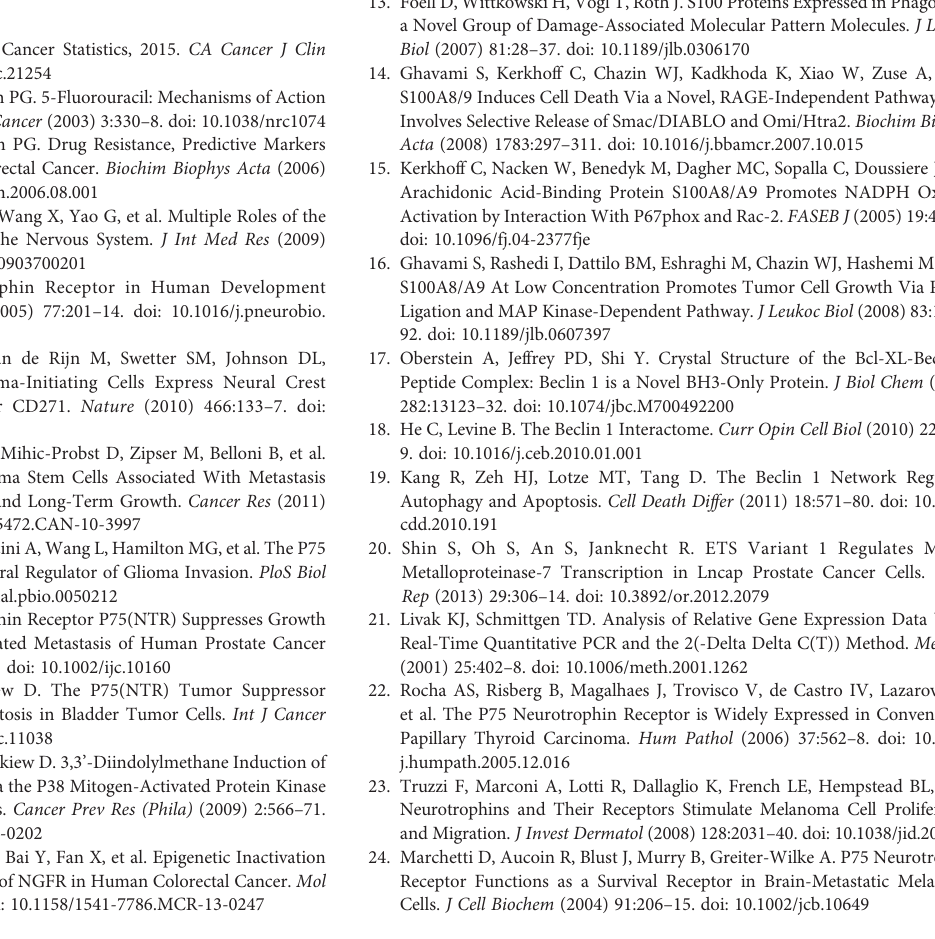
fold change distribution of all probes, excluding the control and fl agged probes. |Fold change| ≥ 1 indicates differentially expressed genes. Supplementary Figure 2 | Volcano plot of the distribution of differentially expressedgenesbetweentheexperimentalandcontrolgroups.Thedottedredand green lines represent the cutoff, a measurement of the gene expression fold change on the X-axis versus a measure of statistical signi fi cance ( − Log10 [P-value]) on the Y-axis. Differentially expressed genes are established at |Fold change| ≥ 1 and P < 0.05 (blue dots). Supplementary Figure 3 | Hierarchical clustering of differentially expressed genes in the experimental and control groups using a Human OneArray v6.1 microarray. A hierarchical clustering tree indicates the gene expression pattern similarities of the 244 genes in the experimental and control groups. The expression levels of the 244 genes are shown by differently colored lumps: red, high (upregulated); black, medium; green, low (downregulated). S100A4, S100A8, and S100A9 are marked in red. Supplementary Figure 4 | NGFR regulate the cell cycle of CRC cells under 5-FU treatment by suppressing TYMS expression and activating 5-FU. (A) TYMS expression was suppressed while NGFR over-expression transfected CRC cells under 5-FU treatment. UMP-CMP kinase expression was elevated while CRC cells were treated with 5-FU, and NGFR transfection can increase those elevation. (B) Compare with empty-vector transfected CRC cells, NGFR transfected CRC cells showed a signi fi cant increase in the number of G1-phase and a signi fi cant decrease in the number of cells accumulating in the S-phase stage after 5-FU